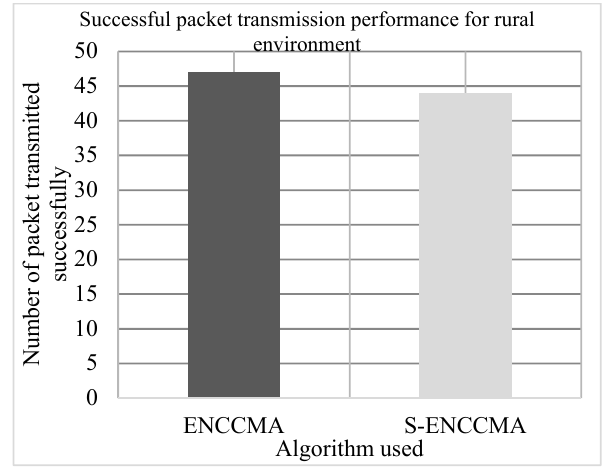
Figure 8. Successful packet transmission performance achieved for a rural environment.